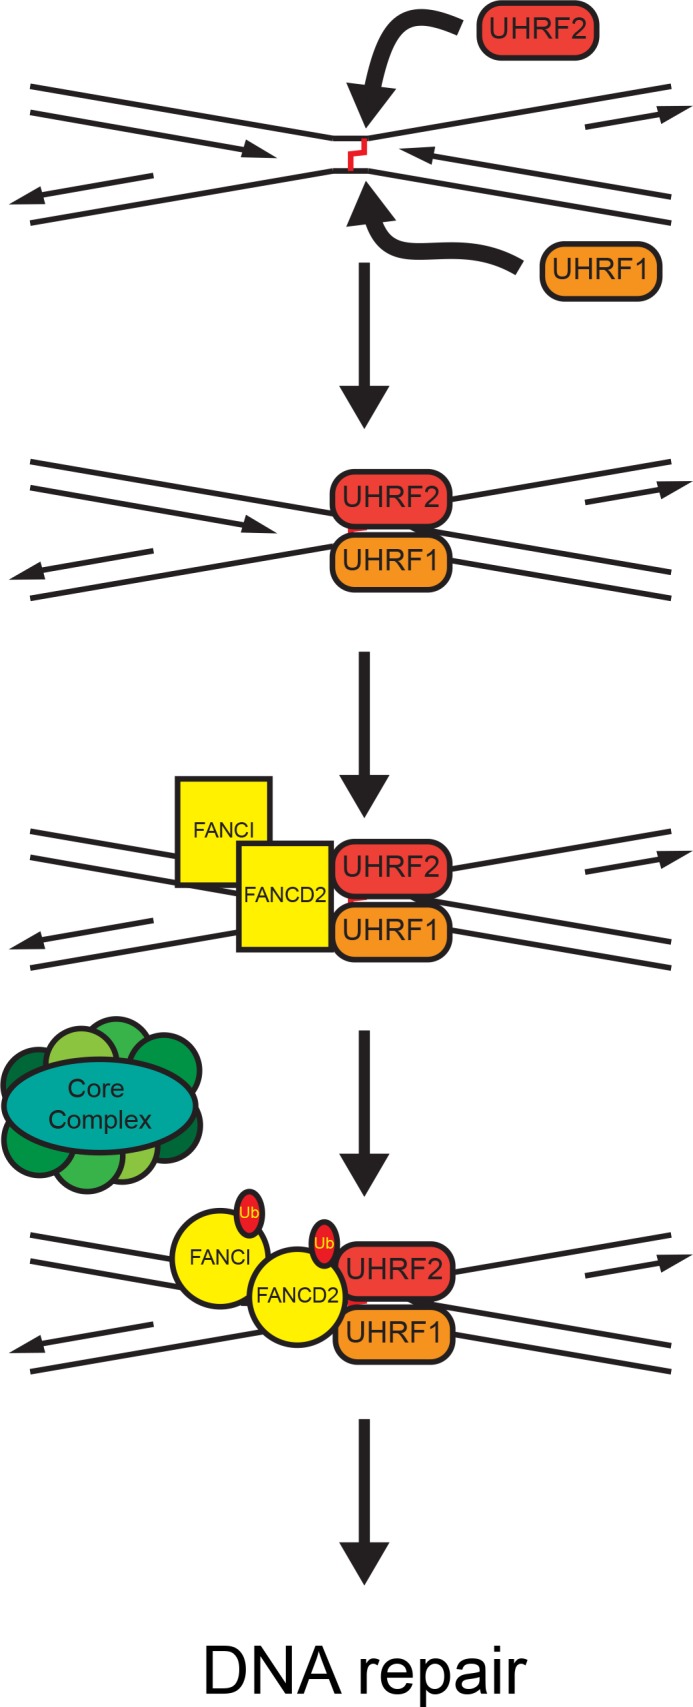
A proposed model of FANCD2 and FANCI recruitment and activation at ICLs via UHRF1 and UHRF2. UHRF1 and UHRF2 are rapidly and independently recruited to the site of the ICL. Recruitment of UHRF1 and UHRF2 facilitate recruitment/retention of the FANCD2/FANCI complex. When FANCD2 and FANCI are bound at the ICL a putative conformational change allows for monoubiquitination by the core complex. The now active FANCD2/FANCI complex activates downstream repair proteins, leading to repair of the ICL.